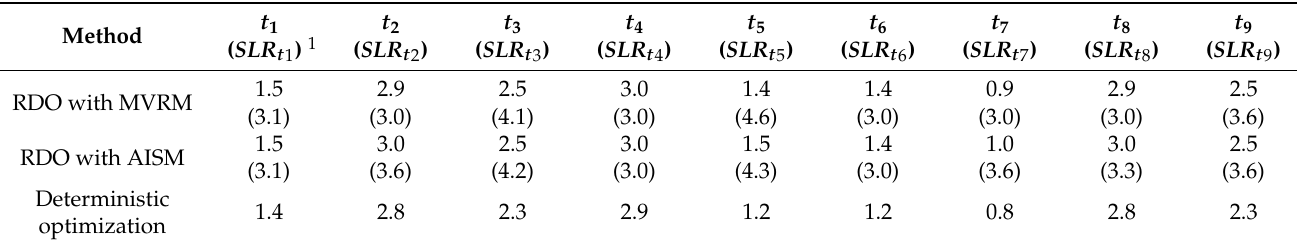
Table 4. Comparison of design optimum (unit: mm).